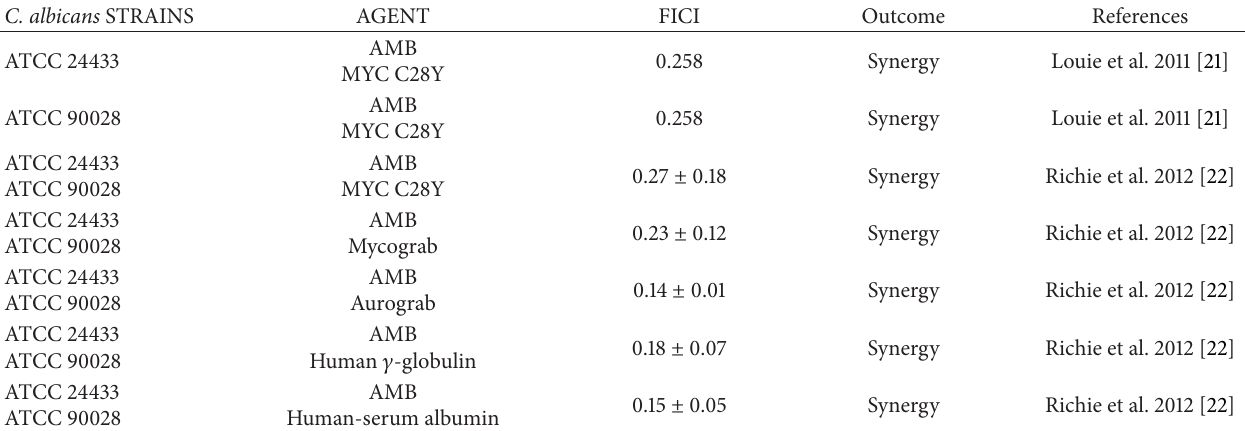
Table 2: FICI of AMB in combination with Mycograb, Mycograb C28Y variant, and various protein sources.